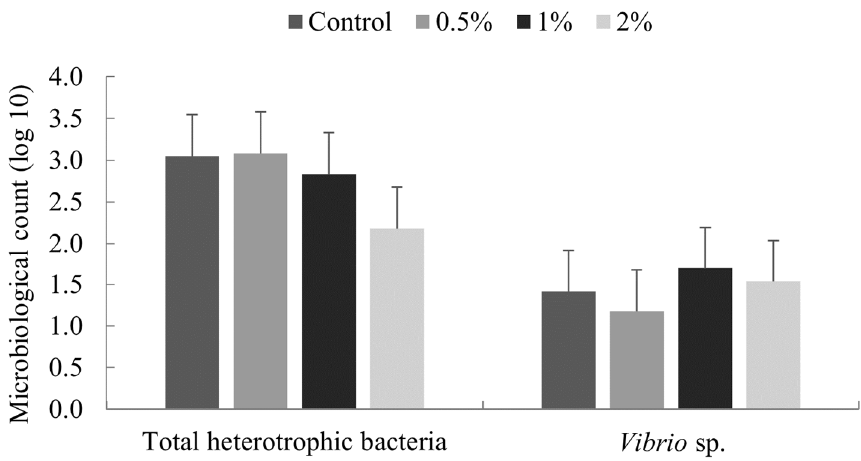
Figure 1. Colony counts of bacteria from the intestine of Litopenaeus vannamei fed for 15 days with diets containing 0, 0.5, 1 and 2% of Nannochloropsis spp. meal. Scale bar indicates the standard deviation of the average ( n =